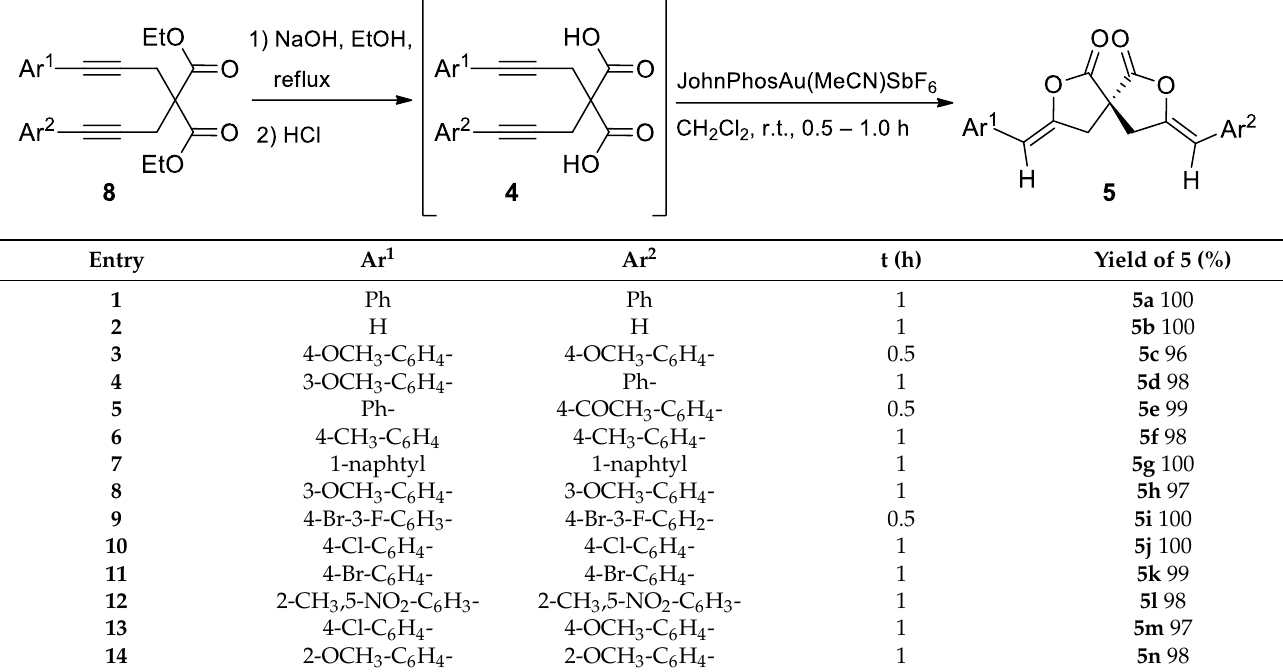
Figure 2. Chemical structure of JohnPhosAu(MeCN)SbF 6 catalyst.